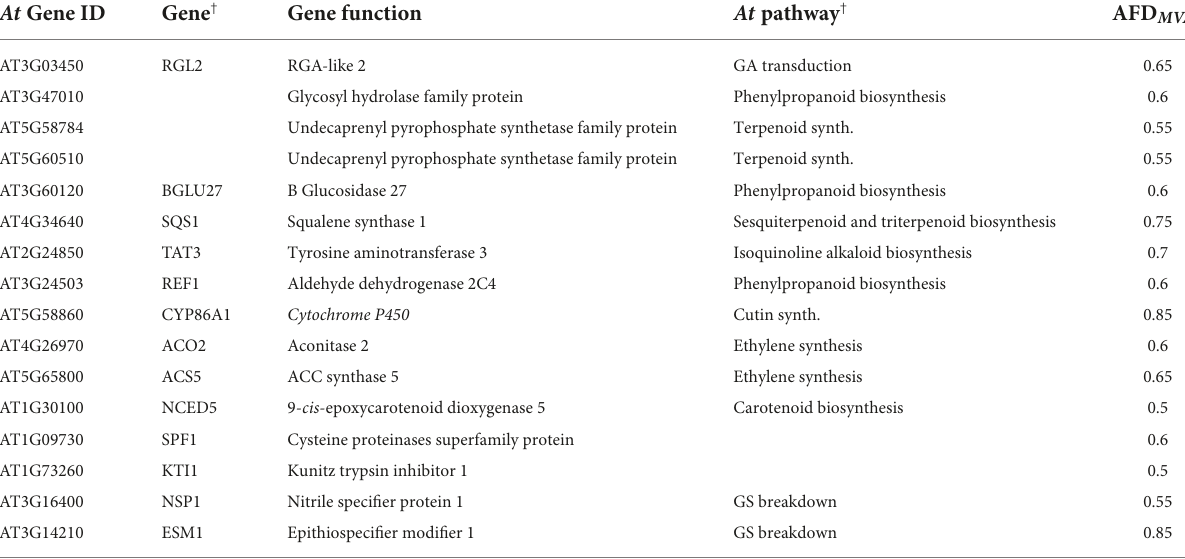
TABLE 4 SNPs with non-synonymous mutations in the CDS regions of genes associated with induced defense against herbivores. At Gene